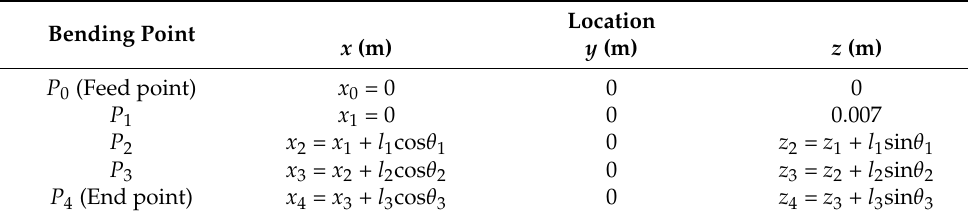
Figure 1. Geometry of the bent wire monopole antenna. Table 1. Locations of the feed point, the bending points, and the end point of the bent wire monopole